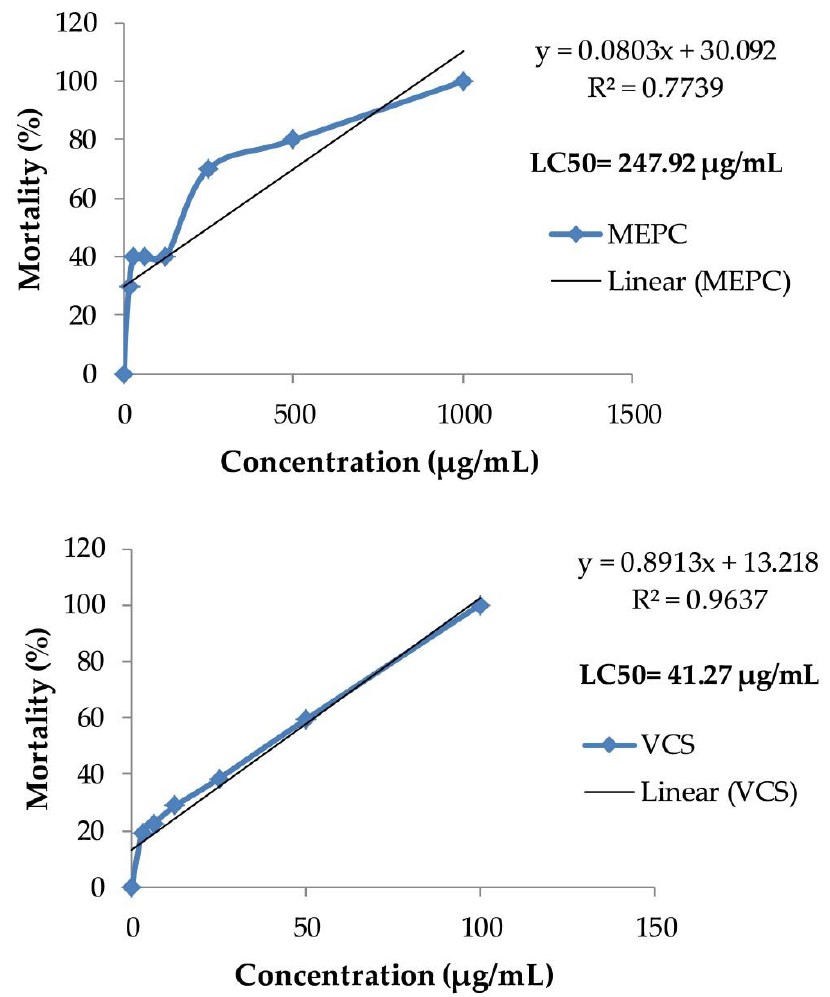
Figure 8. Brine shrimp lethality bioassay of methanol extract of P. calocarpa (MEPC) and vincristine sulfate (VCS). The LC 50 , values of samples were extrapolated using this data.